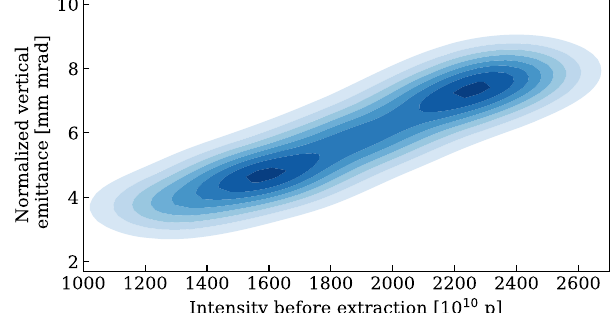
FIG. 6. Distribution of the normalized vertical emittance measured with WS85 before PS extraction as a function of the total beam intensity after the optimization carried out at the PSB. A linear dependence between emittance and intensity is clearly